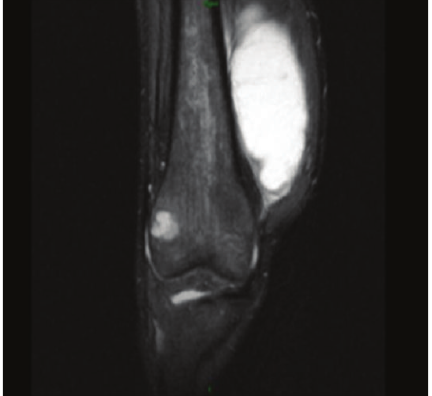
Figure 3: Abscesses around the right knee joint.